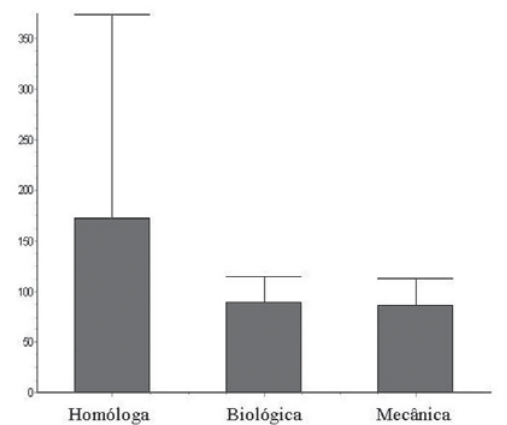
Fig. 1 - Tempo médio de circulação extracorpórea (CEC), em minuto,s com desvio padrão, para os diferentes tipos de próteses. Observa-se que há diferença com significado estatístico desfavorável ao grupo da valva homóloga. Utilizou-se o teste ANOVA não-paramétrico